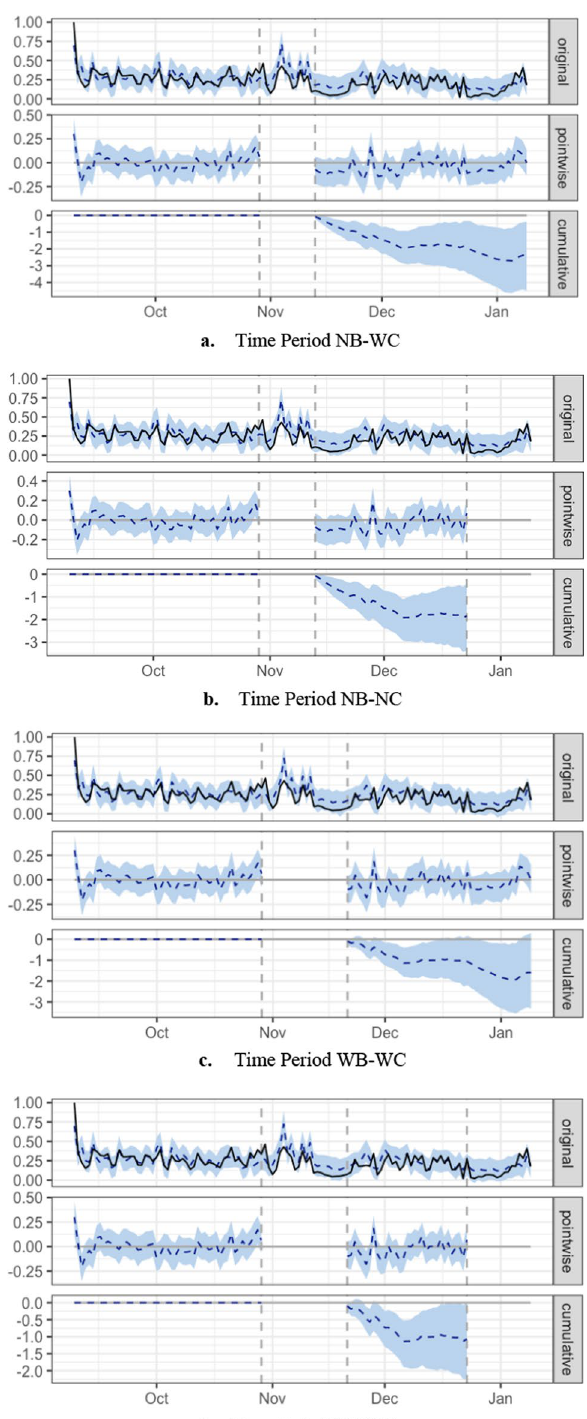
Fig. 2 CausalImpact graphs for all LMS